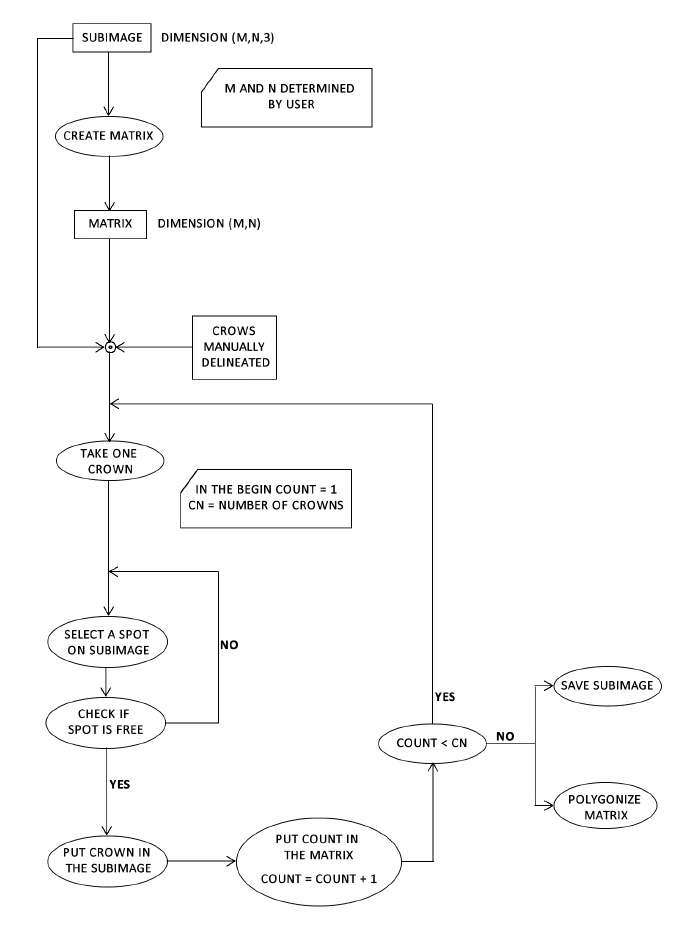
Figure 5. Each step in the algorithm developed for creating synthetic